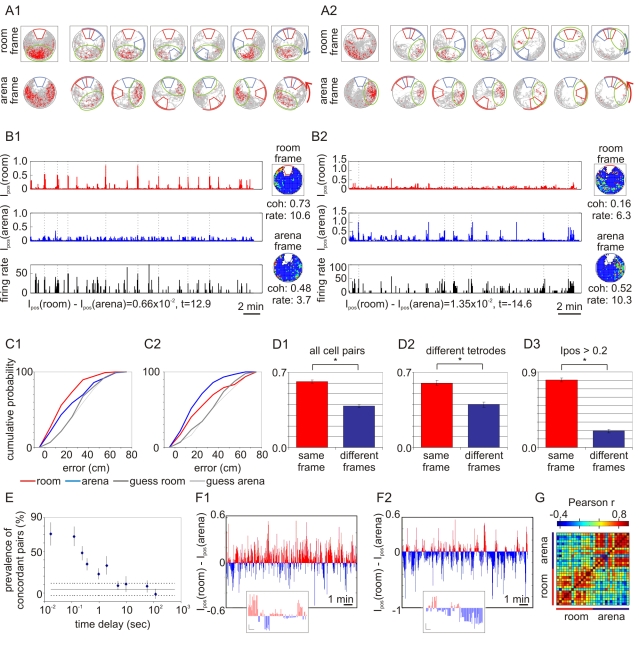
Coordinated frame-specific place cell discharge.(A) Spike maps of a room-preferring cell (A1) and an arena-preferring cell (A2). Frame-specific activity during the whole session is represented in the leftmost column. The other six columns represent activity during different 60° ranges (represented by an arc) of the arena displacement during rotation. (A1) This room-preferring cell fired in the south part of the room (highlighted by the green ellipse) regardless of the arena's orientation in the room. Both measures of spatial firing, average Ipos (0.025) and coherence (0.738), were high in the room frame, but the action potentials were more dispersed across the arena causing lower Ipos (0.009) and coherence (0.484) in the arena frame. (A2) This example of an arena-preferring cell had a firing field with high average Ipos (0.020) and coherence (0.523) in the arena frame. The firing field (highlighted by the green ellipse) was close to the arena shock zone (blue annulus sector). If the rat was willing to visit this region, the cell fired, regardless of the arena's orientation in the room. Firing was dispersed in the room frame, producing low average Ipos (0.006) and coherence (0.162) in this frame. (B) The spatial frame preference was quantified by momentary positional information (Ipos). The time series of Ipos from a single cell in the room frame (red) and Ipos in the arena frame (blue) are shown together with the firing rate (black). The firing rate maps of the cell are shown to the right for both the room and arena frames. The coherence of the rate maps is indicated, as well as the average difference of the Ipos in the two frames. (B1) A room-preferring cell: Instances of high firing rate corresponded to large Ipos in the room frame but not large Ipos in the arena frame. (B2) An arena-preferring cell: Instances of increased firing rate were associated with high Ipos in the arena frame but not Ipos in the room frame. (C) Cumulative probability of errors predicting the rat's position in the room and arena frames during two sessions of the two-frame task. Ensemble discharge predicted both room and arena positions better than chance (paired-sample Wilcoxon test C1—room: N = 162, Z = 6.9, p = 10−11; arena: N = 162, Z = 3.9, p = 10−4; C2—room: N = 158, Z = 3.0, p = 0.003; arena: N = 157, Z = 7.2, p = 10−12). While room position was predicted better than arena position in C1 (N = 162, Z = 3.4, p<0.001), C2 demonstrates the opposite (N = 157, Z = 3.5, p<0.0005). (D) Concordant and discordant discharge was examined in pairs of cells that were active in two 117 ms intervals. Concordant and discordant discharge was equiprobable when the intervals were chosen randomly. In contrast, concordant discharge was more likely when cells were coactive in the same interval (D1) even if the cells were recorded from different tetrodes implanted at least 400 µm apart (D2). The proportion of concordant discharge increased when intervals with Ipos>0.2 in one of the frames were analyzed (D3). (E) The frame preference of cell pairs was assessed for cells firing with different time delays from 17 ms to 120 s. The difference between concordant and discordant cell pairs is shown. Horizontal continuous and dotted lines indicate the average and SEM expected differences for independent frame preferences. (F) Ensemble dynamics of frame preference during two-frame avoidance. Ensemble Ipos was computed as the difference between room and arena Ipos during 1 s intervals for each cell summed across all cells in a single recording. Positive values (red) indicate ensemble preference for the room frame; negative values (blue) indicate preference for the arena frame. Insets show segment of each session in finer temporal resolution (scale Ipos difference: 0.1, time: 1 s). (F1) Room Ipos was greater most of the time (65%), indicating a room-preferring ensemble. (F2) Arena Ipos was greater most of the time (70%), indicating an arena-preferring ensemble. (G) Example of a 15-min recording of 14 cells partitioned into separate room-preferring and arena-preferring ensemble spike time series, each composed only of the 117-ms intervals with a reliable corresponding frame preference (|room Ipos−arena Ipos|>0.2). Ensemble activity vectors were computed every minute from each time series and all pairs of vectors were compared and are illustrated as a chronologically ordered correlation matrix. Concordant vector pairs with the same frame preference were substantially more similar (average correlation = 0.55±0.04) than discordant vector pairs with different frame preferences (average correlation = 0.18±0.01).